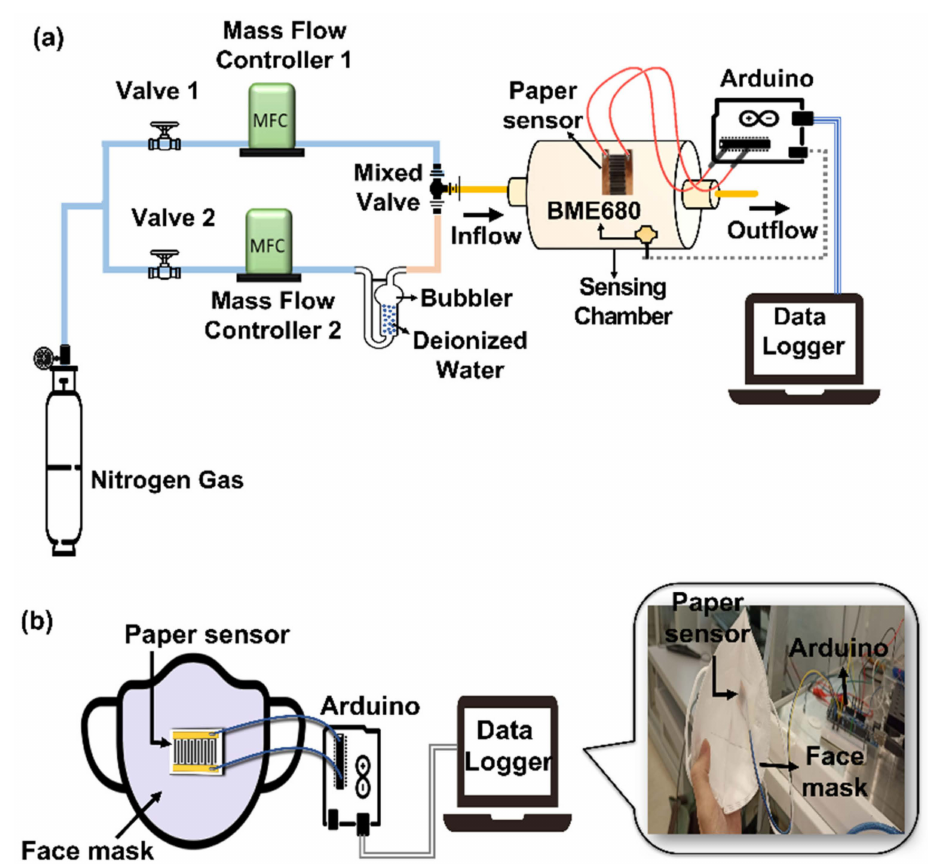
Figure 2. Schematic illustration of ( a ) RH sensing and experimental setup. ( b ) The facemask with the embedded paper-based sensor for breath